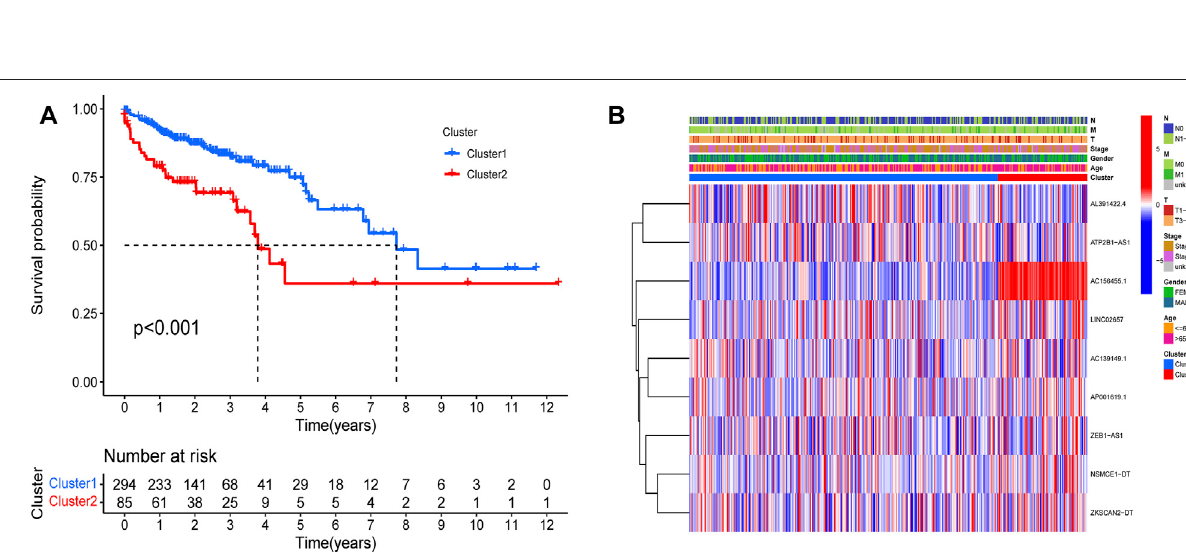
Frontiers in Genetics |